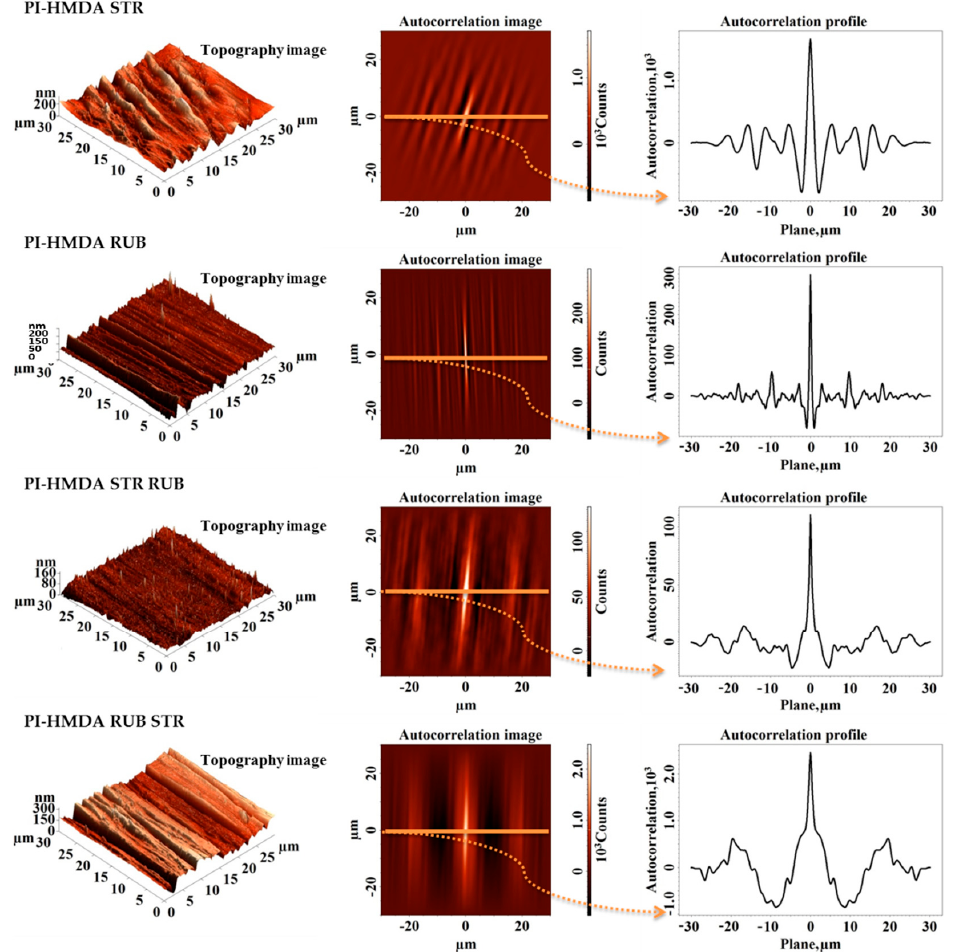
Figure 6. Topography and corresponding autocorrelation images obtained for polyimides PI-HMDA after stretching (STR), rubbing (RUB), rubbing after stretching (STR RUB), and stretching after rubbing (RUB